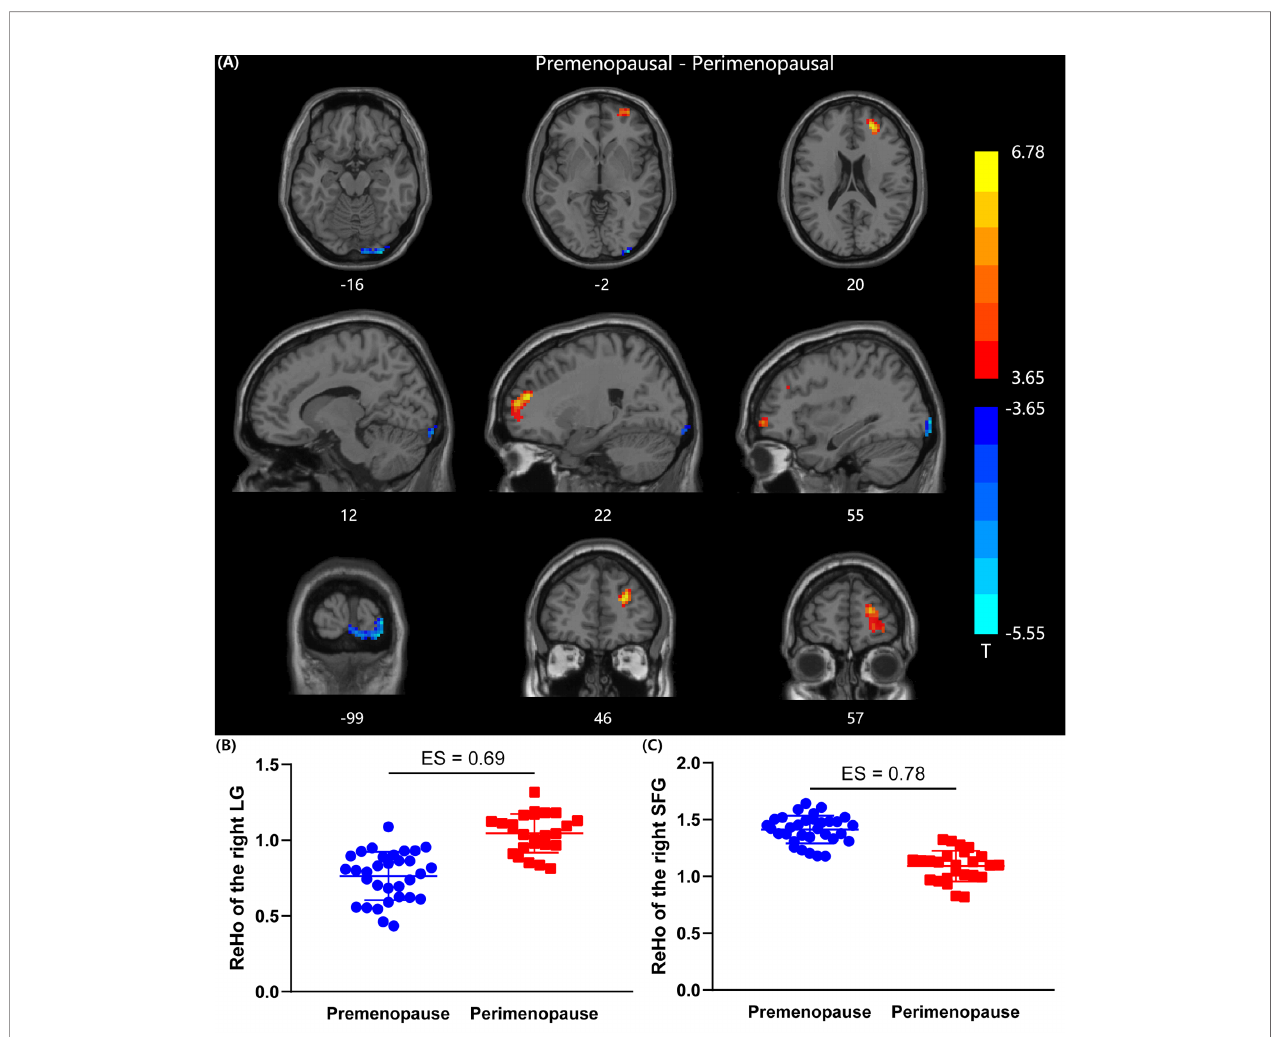
FIGURE 1 | Comparison of ReHo values between premenopausal group (n =32) and perimenopausal group (n = 25). (A) Two sample t-map between premenopausal women and perimenopausal women. Gaussian random fi eld correction (two tailed, voxel-level p < 0.001, cluster level p < 0.05) was used for multiple comparisons, colorbar indicates T-score. (B) Scatter plot of mean ReHo value in the right LG for the two groups. (C) Scatter plot of mean ReHo value in the right SFG for the two groups. LG, lingual gyrus; SFG, superior frontal gyrus; ES, effect